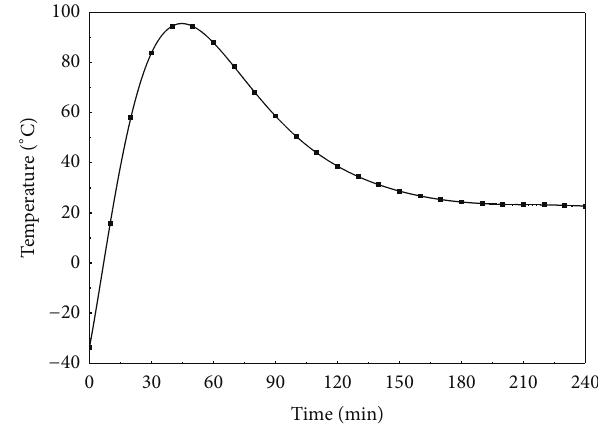
Figure 11: Temperature difference of steam pipe and tube sheet duringprecoolingusingsteamascoolant;steamtemperature:190 ∘ C; pressure: 1.0 MPa; and flow rate: 0.74